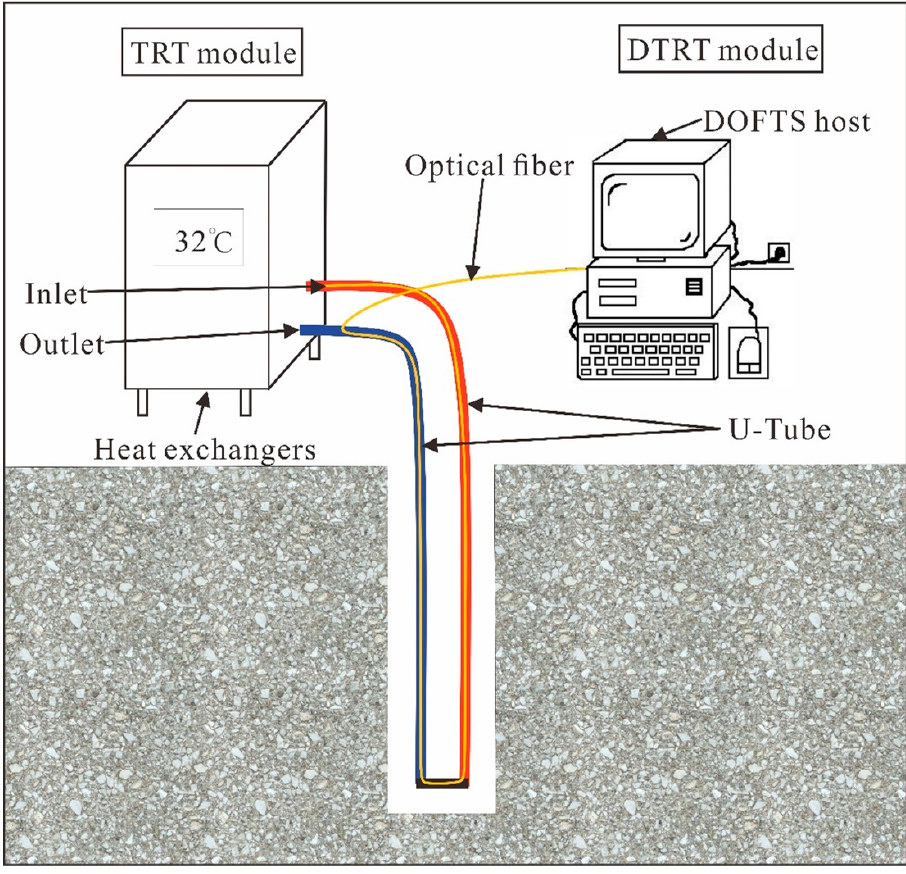
Figure 2. Combined thermal response test system.